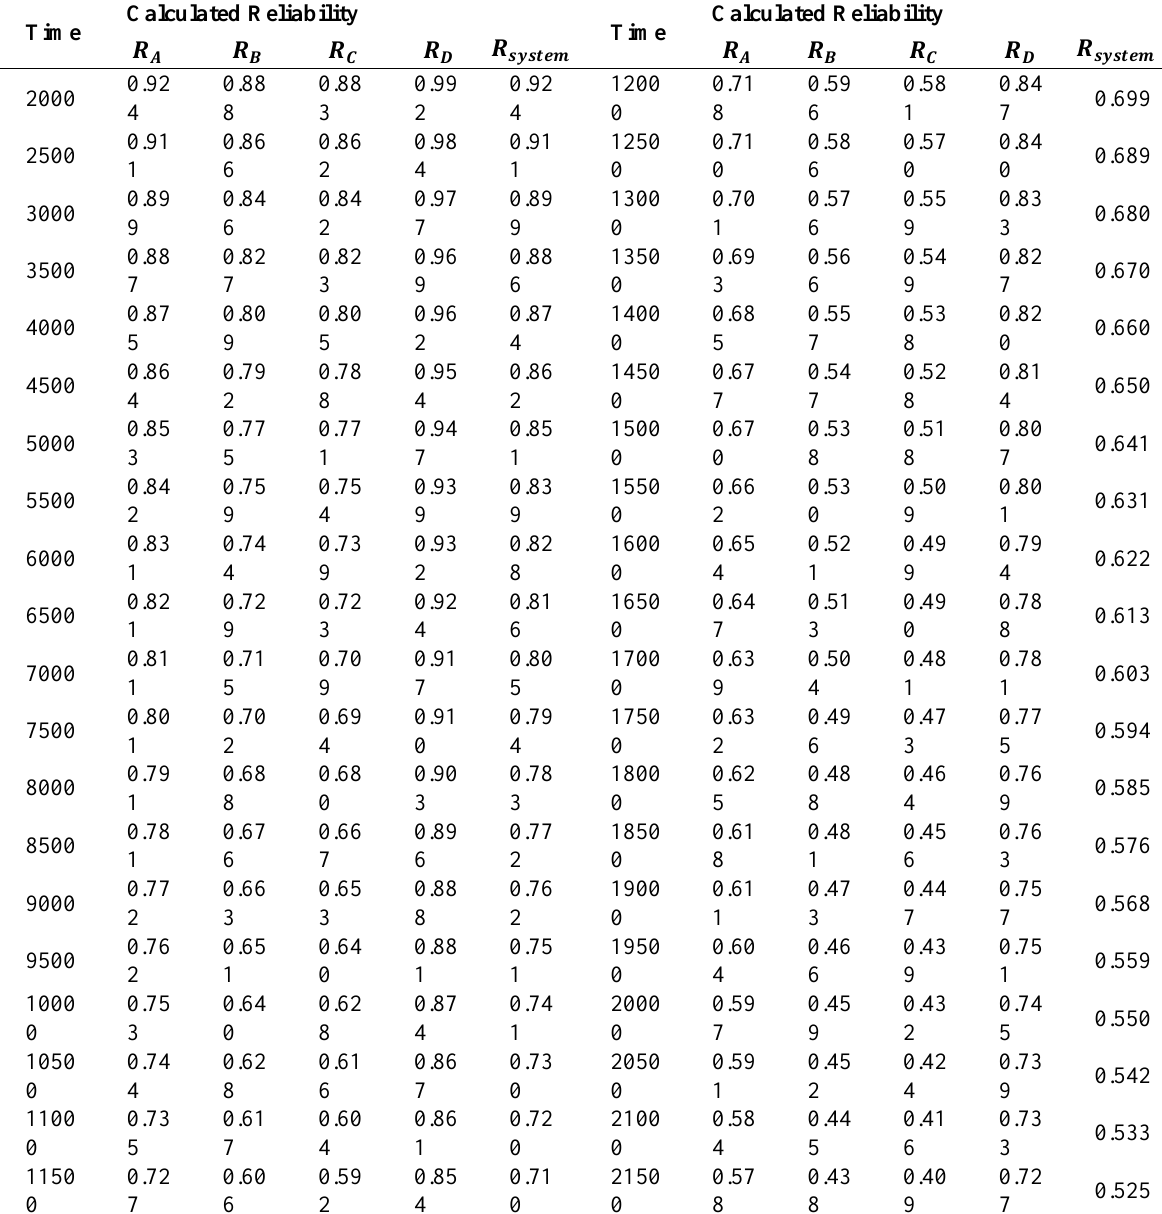
Table 5. Results of system reliability estimation based on the proposed simulation